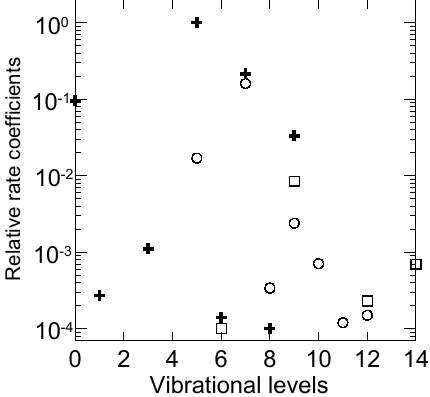
Fig. 6. The same as in Fig. 5 but for vibrational level v =1 of the Figure 6. The same as in Fig.5 but for vibrational level v=1 of the O 2+ (X 2 Π g ) ion. (X 2 5 g ) ion. O + 2